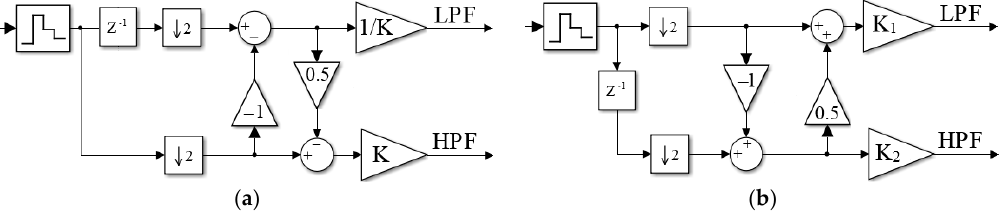
Figure 8. Simulated block diagrams for the Haar mother wavelet based on: ( a ) first general lifting-scheme; and ( b ) second lifting-scheme (Section 2).